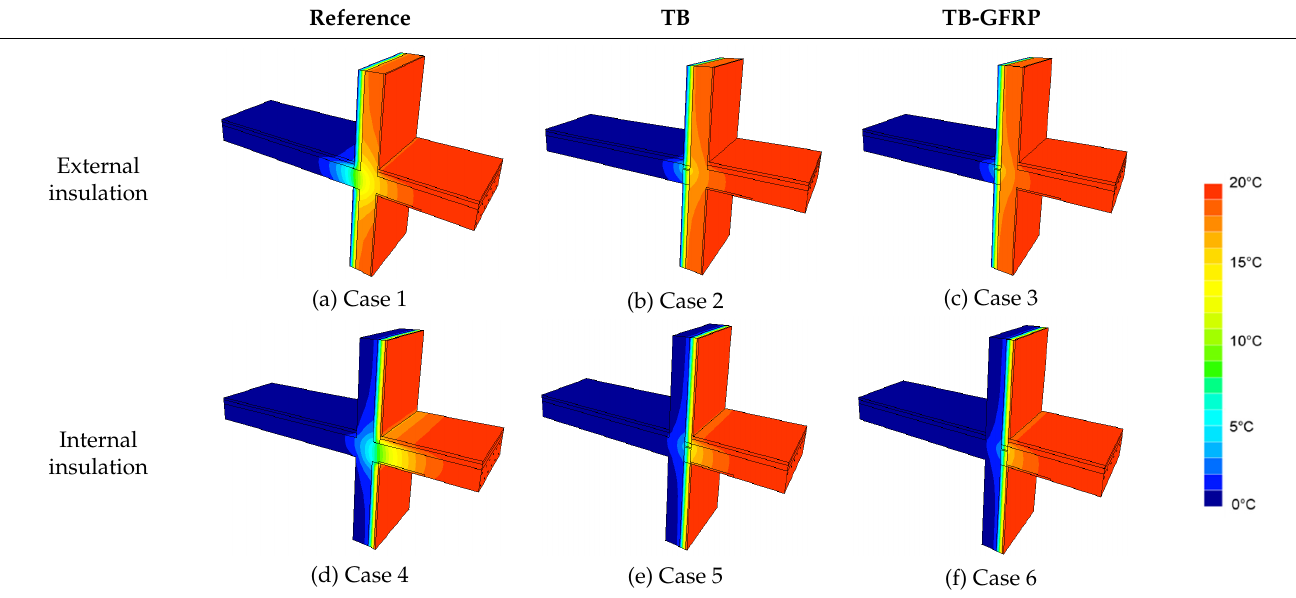
Table 5. Simulation results of heat transfer under air heating condition.